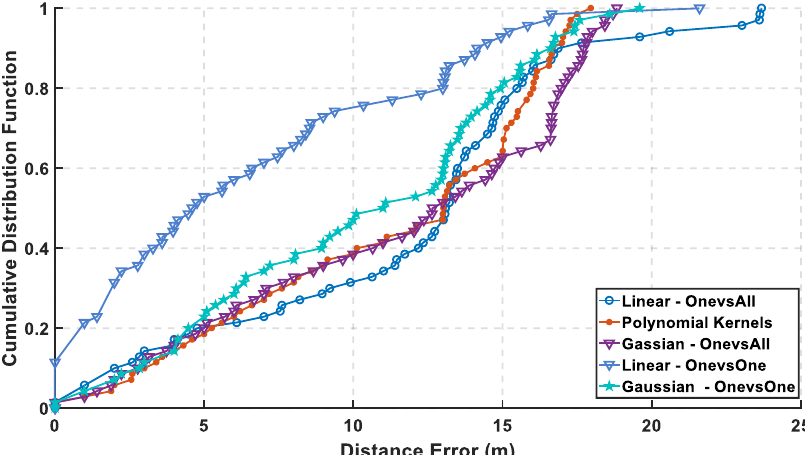
Figure 10. Cumulative Distribution Function using One-Versus-One and One-Versus-All Approaches for SVM using the 18th PC .